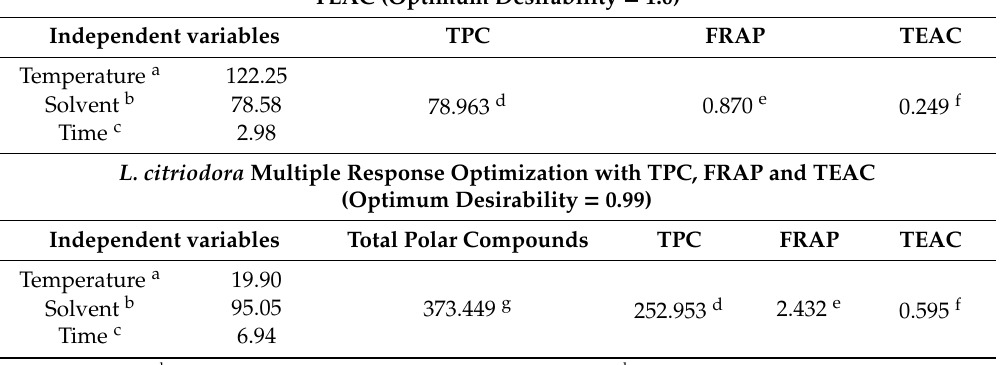
Table 9. Multiple response optimization analysis in H. sabdari ff a and L. citriodora . H. sabdari ff a Multiple Response Optimization with Total Polar Compounds, TPC, FRAP and